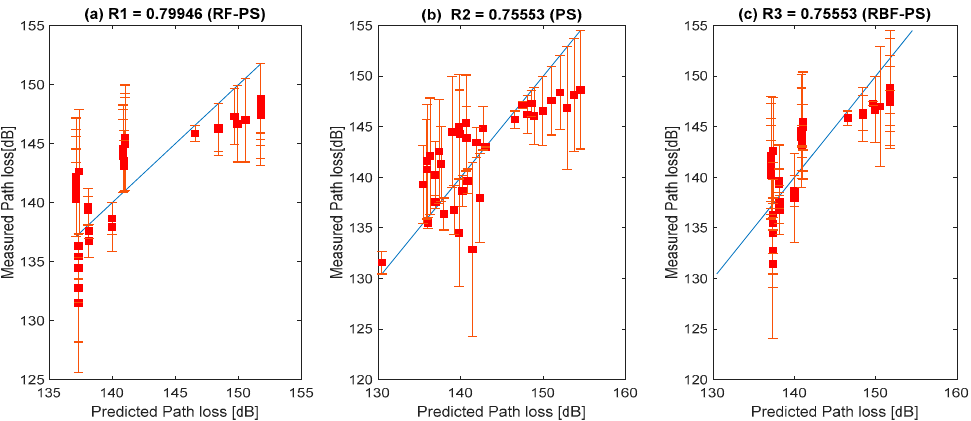
Figure 25. Results showing the correlation between the measured path loss and predicted path loss using the hybrid RF-PS prediction method and two existing standard path loss prediction methods in site 3 of location 2.